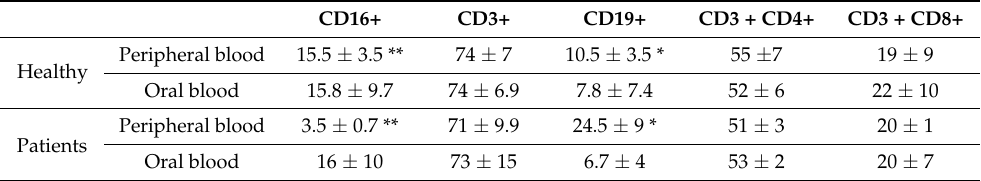
Table 1. Percentages of lymphocyte cell subsets in peripheral and oral blood of healthy individuals and periodontitis